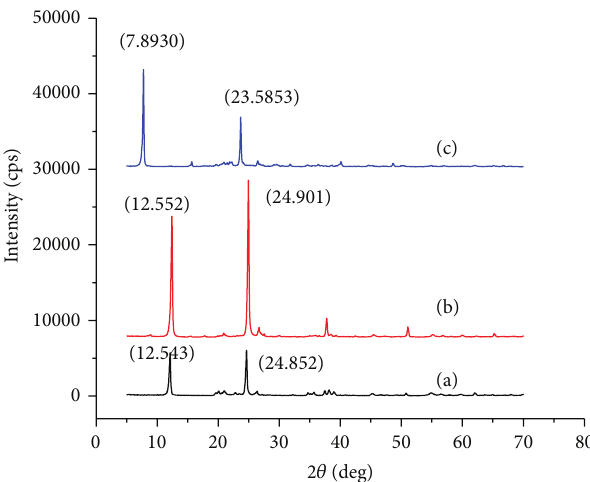
Figure 3: X-ray diffractograms of (a) beneficiated Pugu kaolinite, (b) NaKP, and (c)